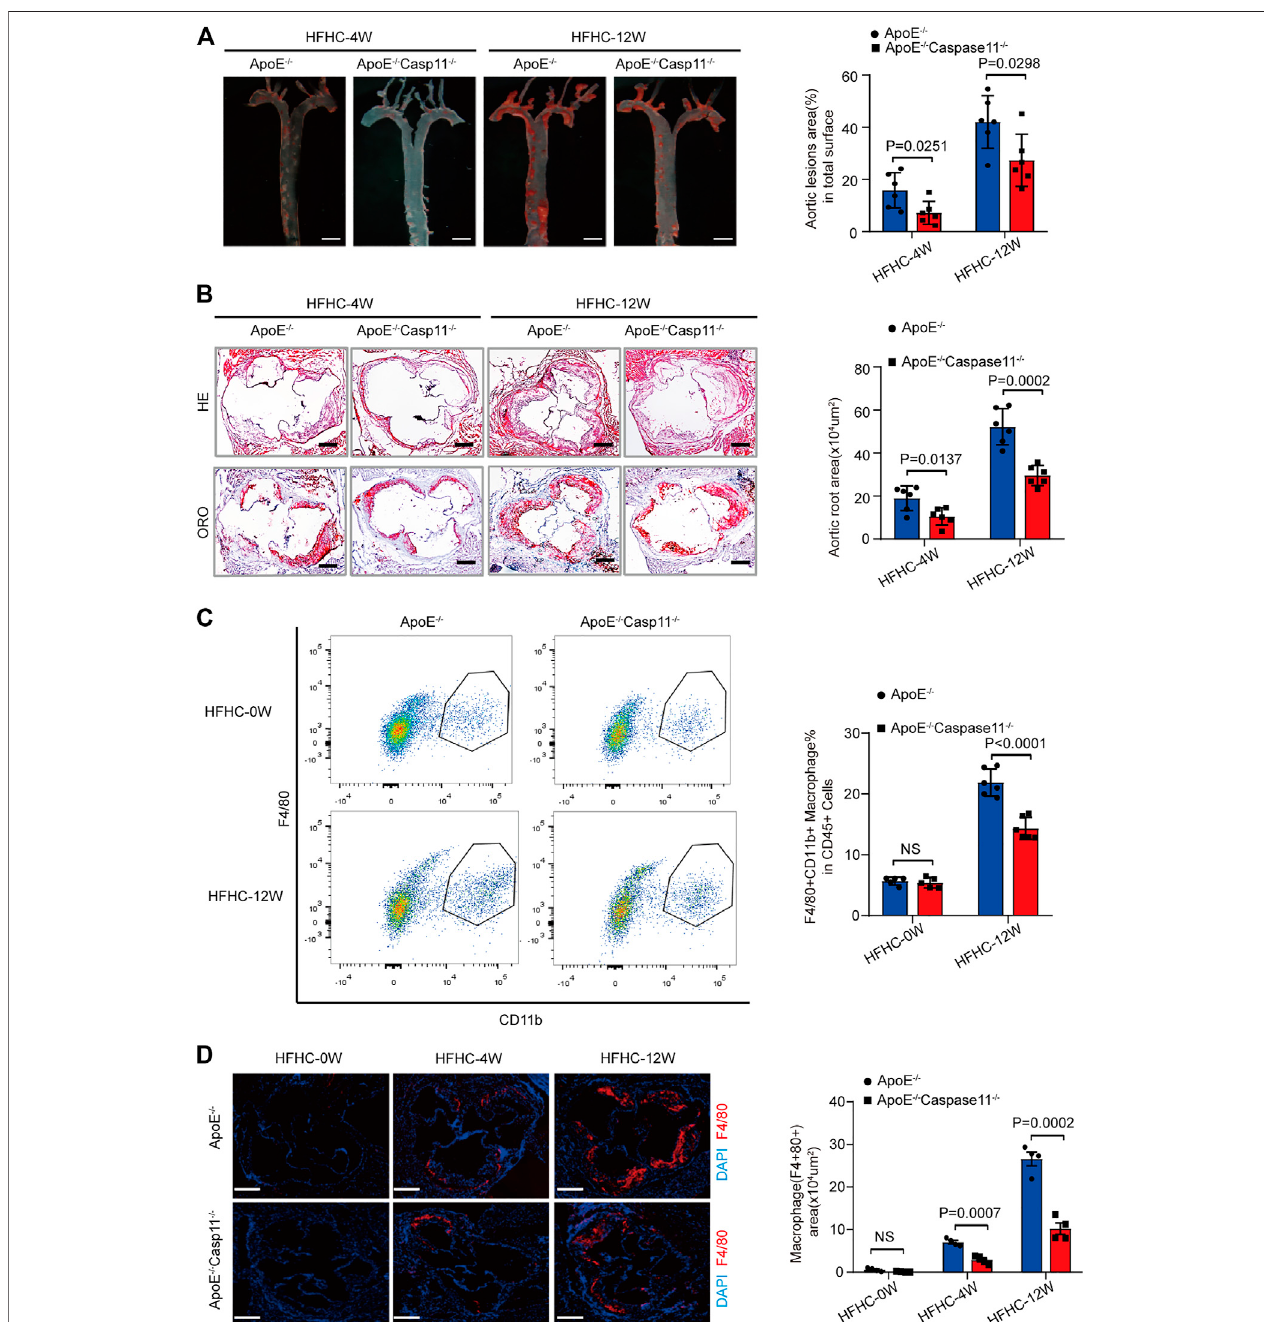
FIGURE 3 | Genetic deletion of caspase-11 attenuated atherosclerosis plaque progression and macrophage in fi ltration in ApoE − / − mice. (A) Left, overall comparison of representative whole-aortas stained with Oil-Red-O staining ( n (cid:2) 5 mice per group; scale bar, 1 mm). Right, quantitative results of the stained area in the entire aortas in ApoE − / − and ApoE − / − Caspase-11 − / − mice with 4 or 12-week HFHC diet. (B) Left, histological analysis of aortic root sections stained with H&E and ORO staining in the aortic root sections in ApoE − / − and ApoE − / − Caspase-11 − / − mice after 4 or 12-week HFHC diet ( n (cid:2) 5 mice per group; scale bar, 100 μ m). Right, quantitative results for the lesion formation in the aortic root sections in the indicated groups ( n ≥ 20 fi elds per group). (C) Left, fl ow cytometric analysis of aortic macrophage content, determined as F4/80+CD11b+ cells per aorta and statistical results for aortic macrophage content in ApoE − / − and ApoE − / − Caspase-11 − / − mice after 0and12-week HFHCdiettreatment ( n (cid:2) 5miceper group). Right,quantitativeresultsof fl owcytometric analysis. (D) Left,representativeimages ofF4/80(red)and DAPI (blue) in aortic root sections in ApoE − / − , ApoE − / − Caspase-11 − / − mice after 0, 4 and 12-week of HFHC treatment ( n (cid:2) 5 mice per group; scale bar, 100 μ m). Right, quanti fi cationanalysisoftheF4/80positiveareaofaorticrootsectionsintheindicatedgroups( n ≥ 20 fi eldspergroup).Datashownaremean ± SD (A – D) .Datawere fi rst analyzedand passed normality test (Shapiro-Wilktest). p valueswereshown andassessed byMann-Whitney test (A – D) . Allofthe p values werelabeled on thepictures and p < 0.05 was considered to indicate statistical signi fi cance. ORO, Oil-Red-O; H&E, hematoxylin and eosin; HFHC, High fat and high cholesterol.